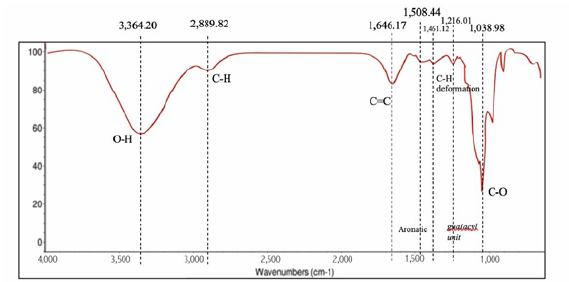
Fig. 5. FTIR Spectrum Results of Caustic Soda Crude Extract Powder